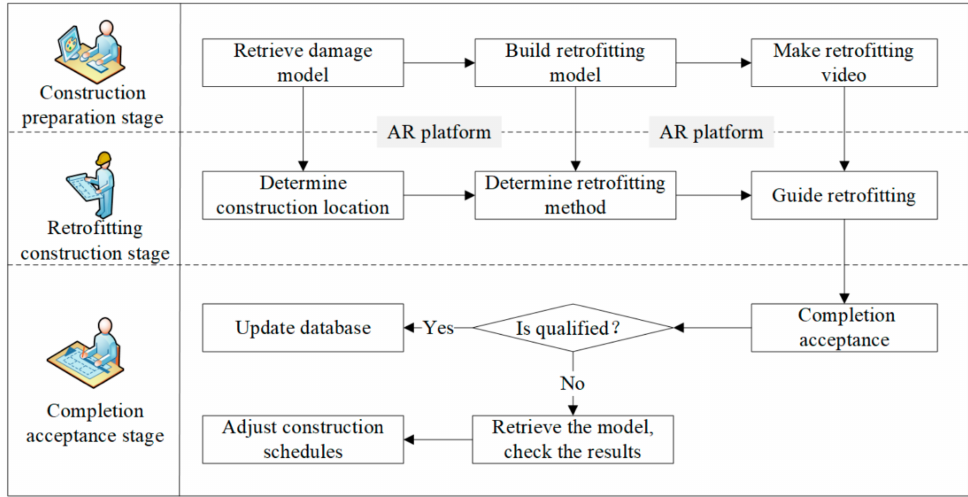
Figure 5. Information transfer flow in